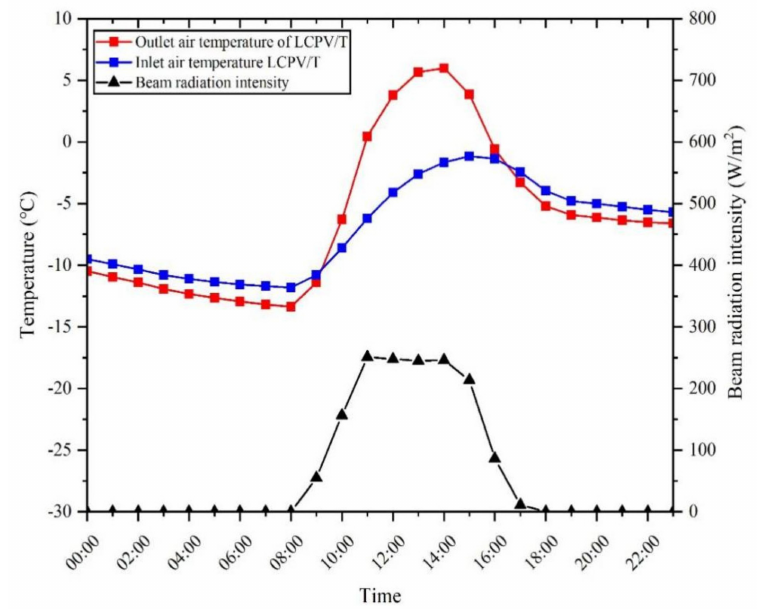
Figure 4. Inlet and outlet temperature of LCPV/T on 15 January.